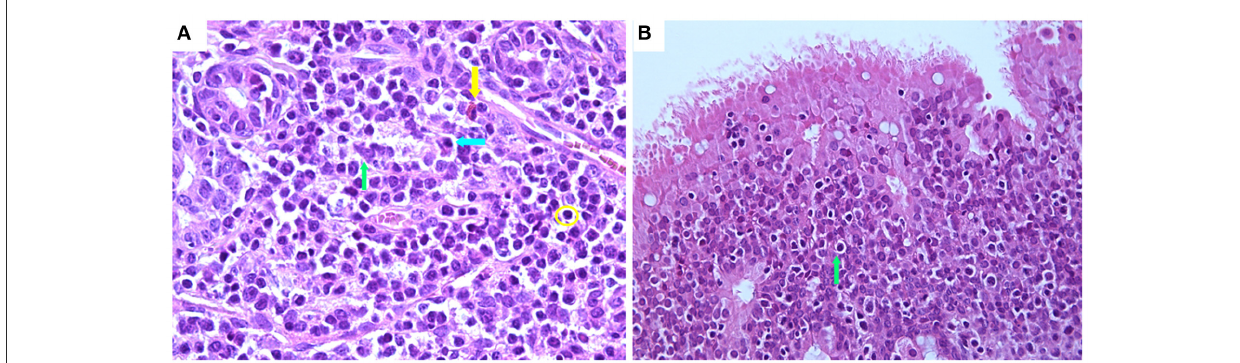
FIGURE7 Histological features of nasal mucosa sections in the IN-vaccinated (nano-adjuvanted dry powder vaccine) group at 7 days PV. (A) Immune cell infiltrate within lamina propria mainly composed of lymphocytes (yellow circle), plasma cells (blue arrow) and macrophages (green arrow) with rare eosinophils (yellow arrow) (630 × magnification); (B) numerous intraepithelial lymphocytes within epithelium (green arrow) (400 × magnification). IN, intranasally.